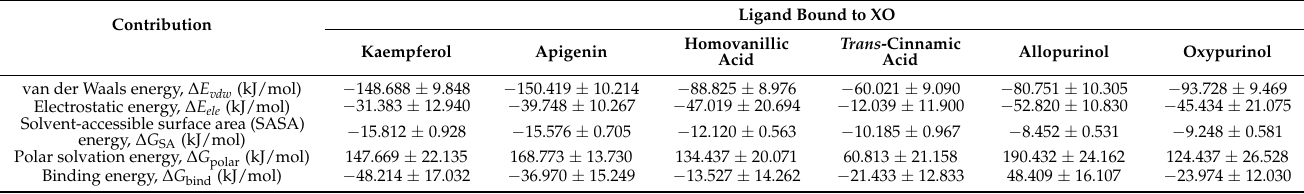
Table 1. The binding energy between the four ligands and XO is predicted by the MM/PBSA method.